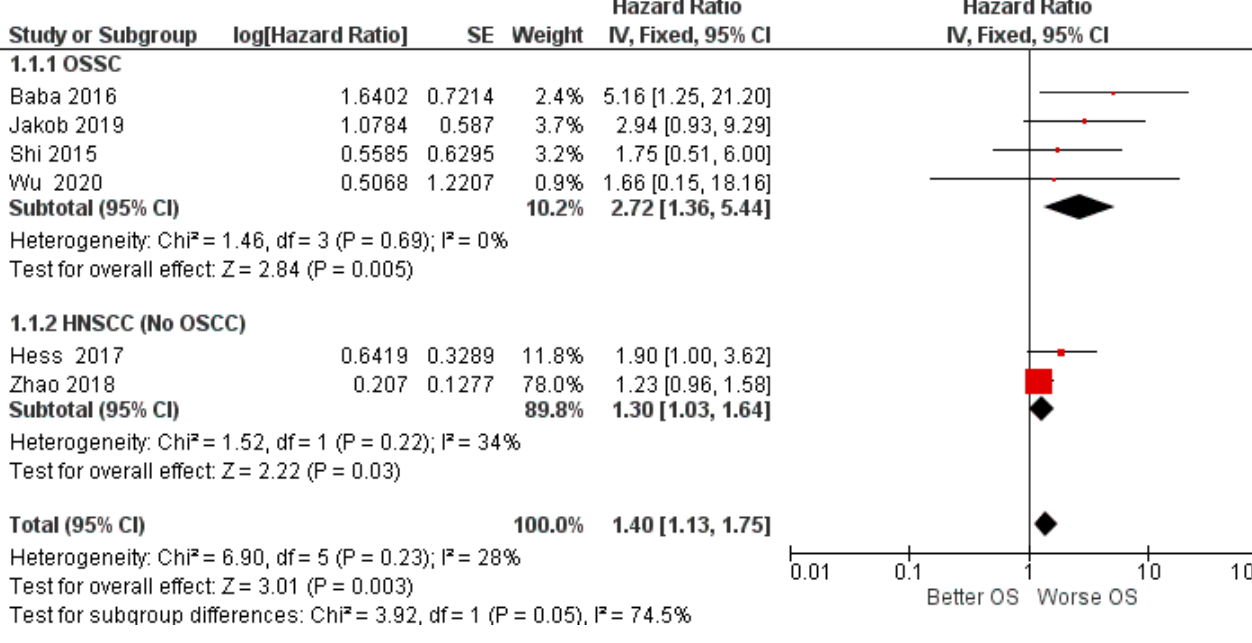
Figure 7. Forest plot of the fixed effects model of the subgroup meta-analysis for OS.